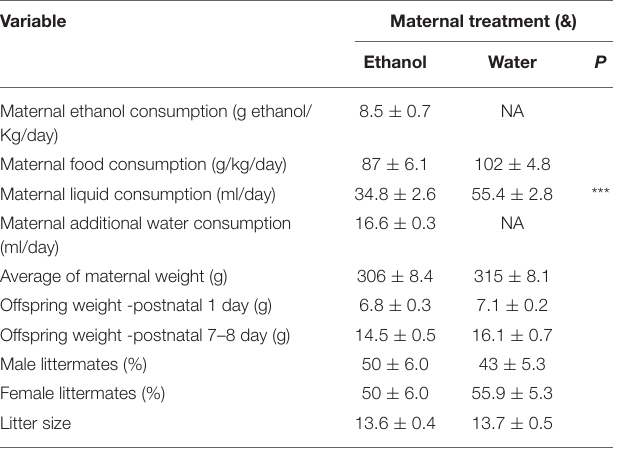
TABLE 2 | Effects of forced ethanol (10%) consumption on rat dams and their offspring. Variable